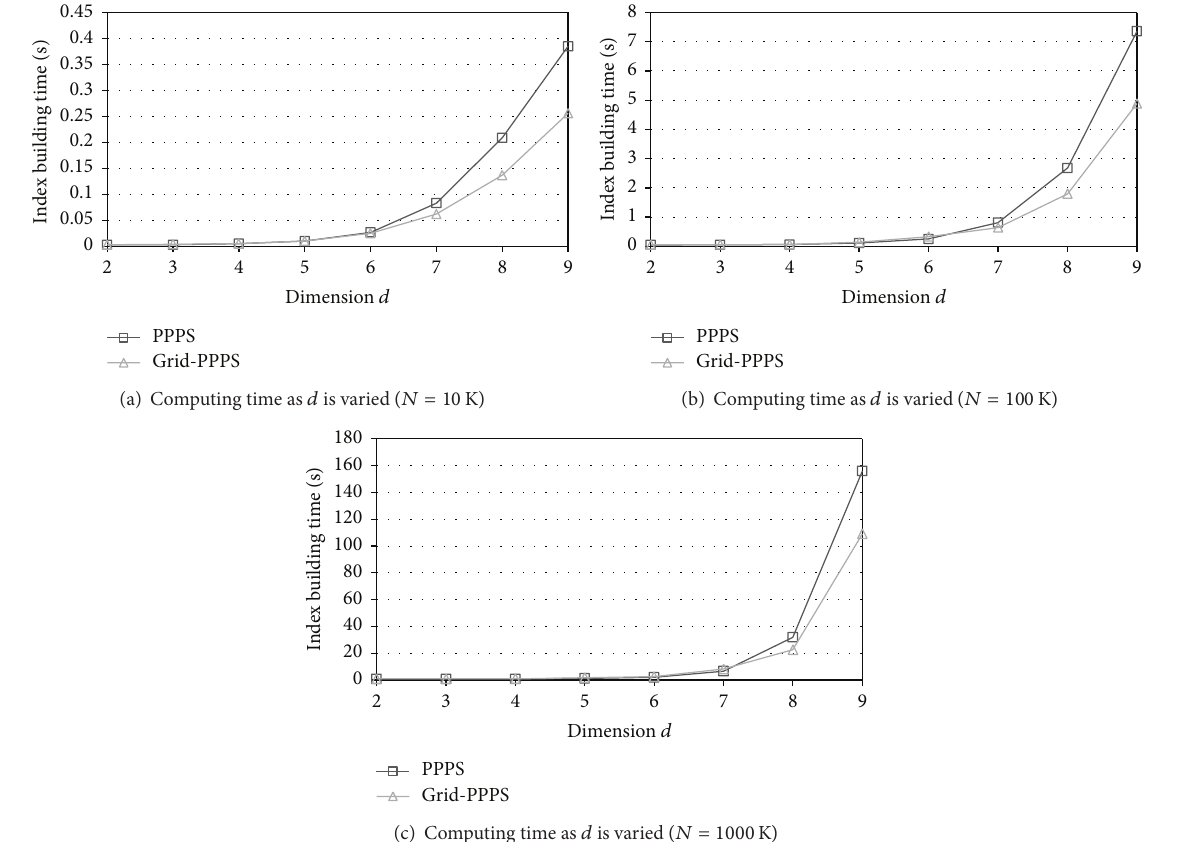
Figure 6: The comparison of the computing time of the Grid-PPPS and PPPS as 𝑑 and 𝑁 are varied related to Experiment